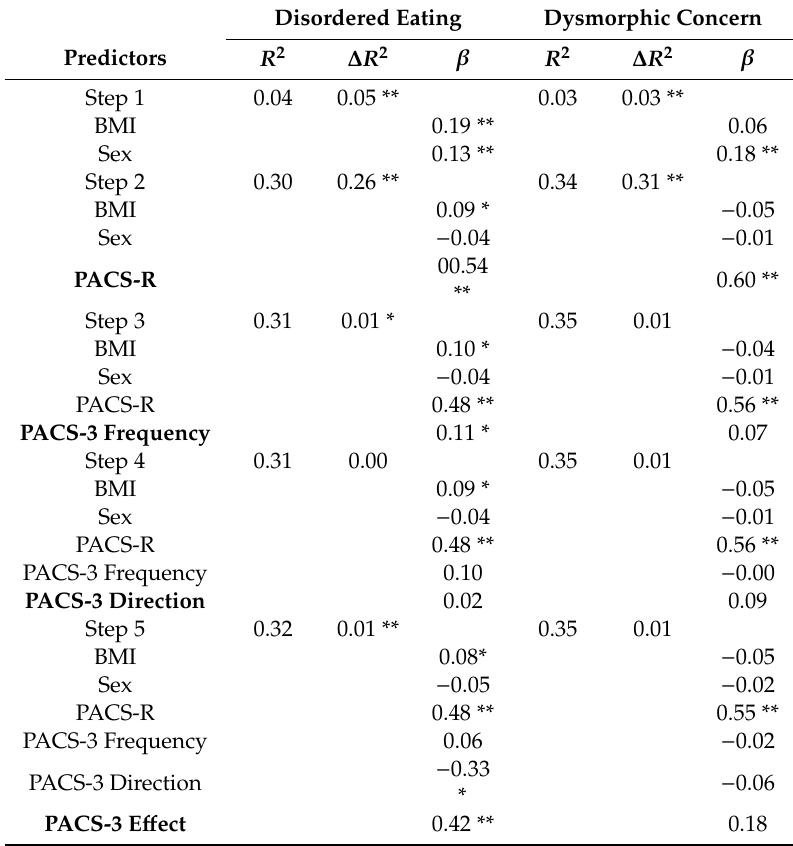
Table 3. Summary hierarchical regression analysis predicting disordered eating and dysmorphic